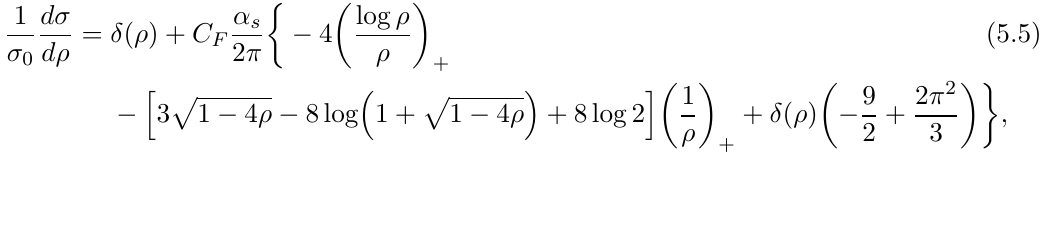
Figure 10 . The results for the (cid:12)xed order and resummed di(cid:11)erential cross section of the plain and soft-dropped e (2) for e + e (cid:0) collisions at a centre of mass energy Q = m Z and the soft drop 2 parameters z cut = 0 : 1 and (cid:12) = 0. The (cid:12)gure shows LO for plain e (2) dropped e (2) (magenta dashed-dotted) and the matched LO+NLL 0 cross section for plain e (2) 2 dotted) and soft-dropped e (2) (red solid) In addition the resummation without taking into account 2 transition point e(cid:11)ects is shown (green dotted). Right shows the end-point corrections included with the bands from resummation and scale